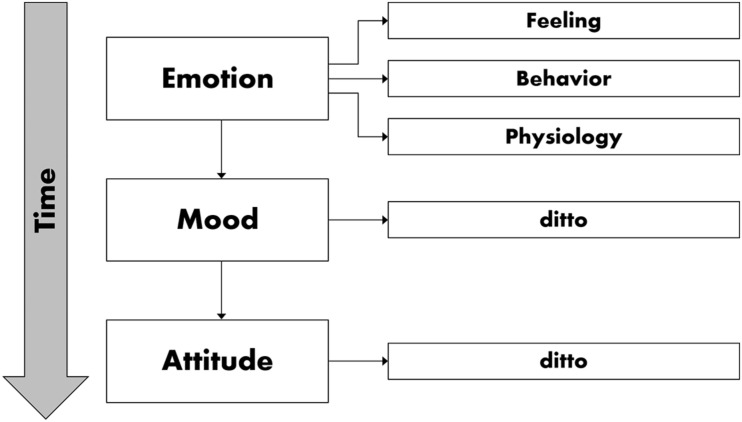
Simplified model of emotion adapted from Gross (Gross, 2010).